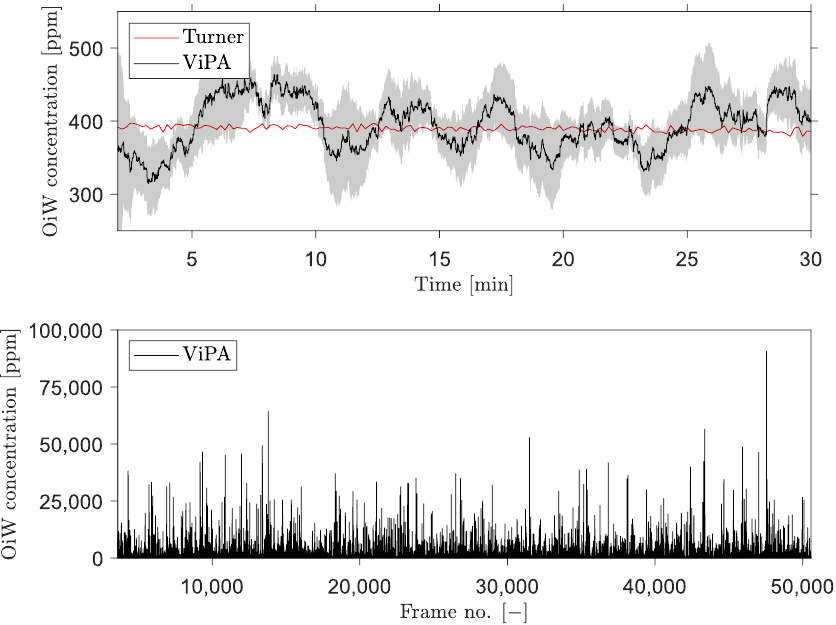
Figure 18. Same procedure as in Figure 16 for real-time OiW concentration measurement based on captured images from C 2 at another measurement range of ∼ 400